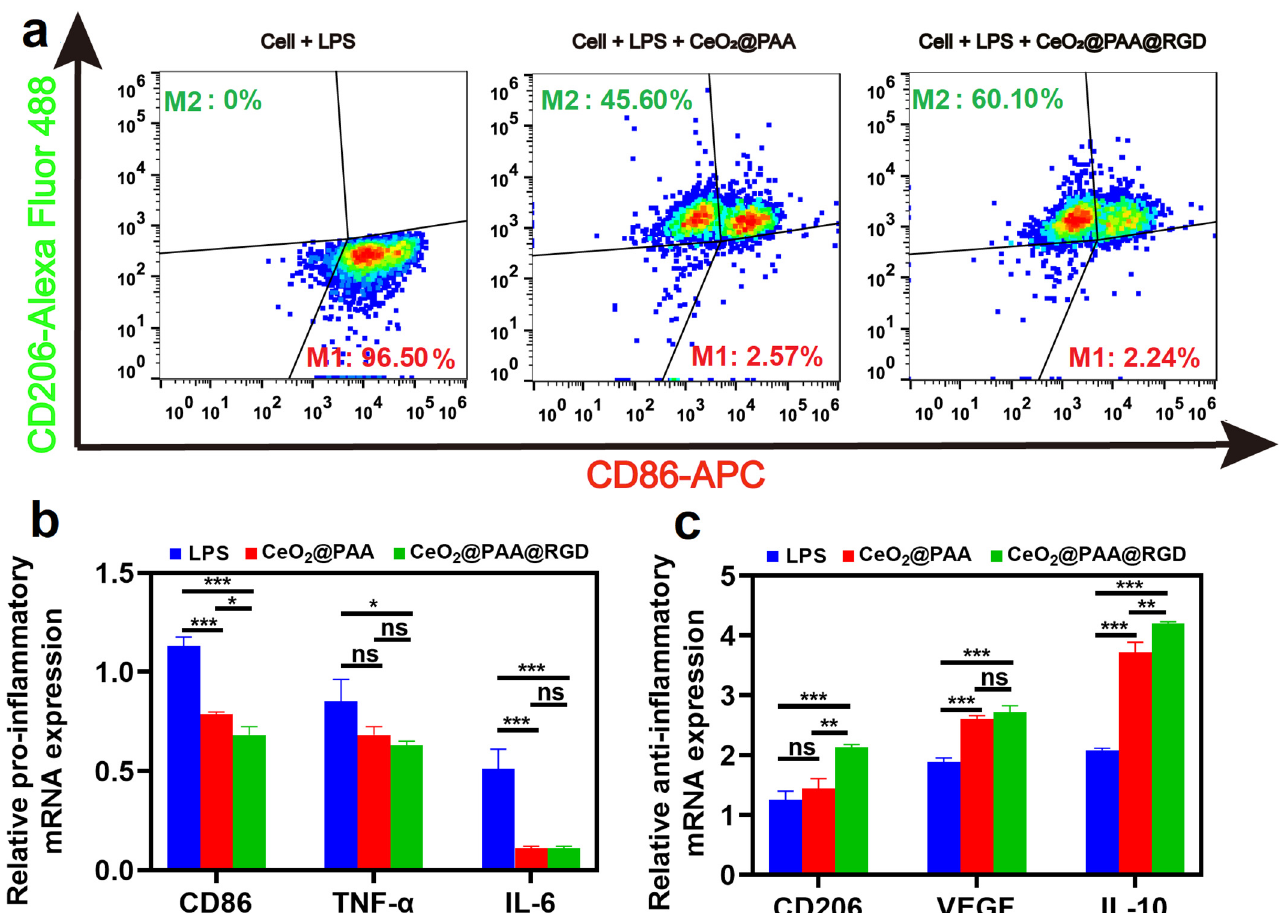
Figure 4. CeO 2 @PAA@RGD regulates the phenotype and function of macrophages by flow cytom- etry and qRT-PCR analysis. ( a ) Flow cytometry plots of CD86 and CD206 expression levels in macrophages after 24 h of CeO 2 @PAA or CeO 2 @PAA@RGD treated; ( b ) qRT-PCR was performed to detect the expression of proinflammatory factors CD86, TNF- α , and IL-6; ( c ) qRT-PCR was used to examine the expression of anti-inflammatory factors CD206, VEGF, and IL-10. Error bars = mean ± standard deviation (SD) ( n = 3); ns > 0.05, * p < 0.05, ** p < 0.01, *** p < 0.001, using a one-way ANOVA (and nonparametric or mixed).